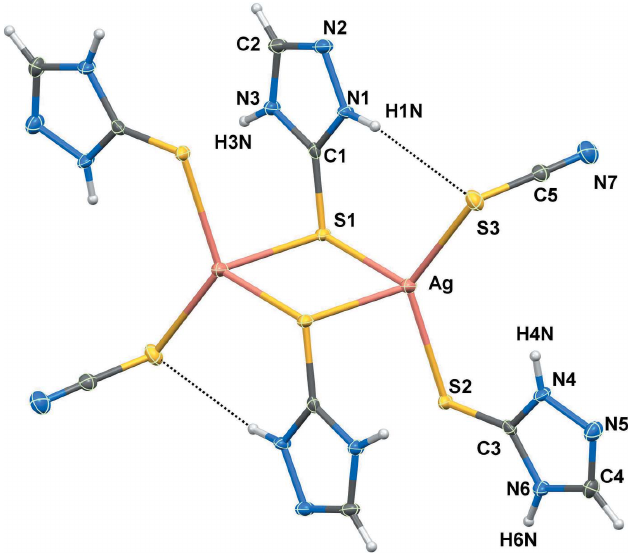
Figure 1 The molecular structure of (I) showing displacement ellipsoids at the 70% probability level. The unlabelled atoms are generated by the symmetry operation 1 (cid:4) x , 1 (cid:4) y , 1 (cid:4) z . The dashed lines represent intramolecular amine-N—H (cid:2)(cid:2)(cid:2) S(thiocyanato) hydrogen bonds.